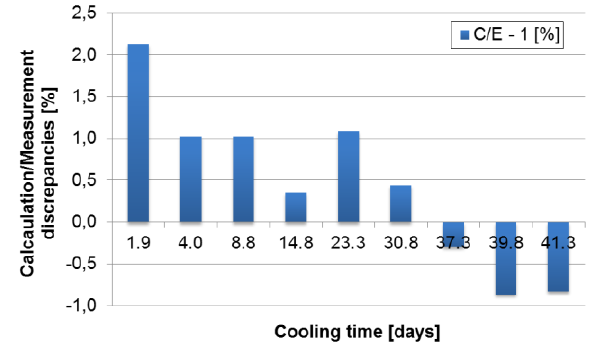
Fig. 4. MERCI-1 calculation/experiment discrepancies (C/E -1) for the nine cooling times